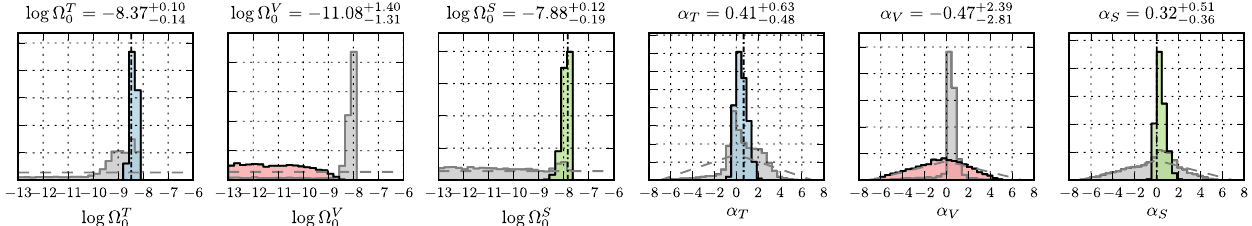
FIG. 15. Marginalized amplitude and slope posteriors for the mixed tensor and scalar background observation in Fig. 14, after the additional inclusion of design-sensitivity Advanced Virgo. For reference, the light gray histograms show the Advanced-LIGO-only results from Fig. 14. In contrast to the results in Fig. 14, the degeneracy between polarization modes is completely broken when including Advanced Virgo. Thus, while Advanced Virgo does not particularly improve prospects for the detection of a mixed background, it can significantly improve our ability to perform parameter estimation on multiple modes